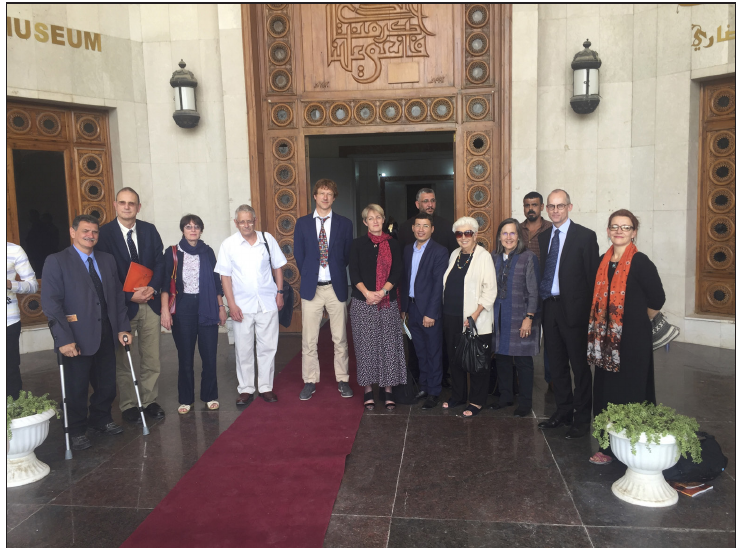
Figure 1: Lamia Al-Gailani Werr (centre right, in white jacket) with colleagues from Friends of Basrah Museum and the British Institute for the Study of Iraq, at Basrah Museum, September 2016 (Photo: Basrah